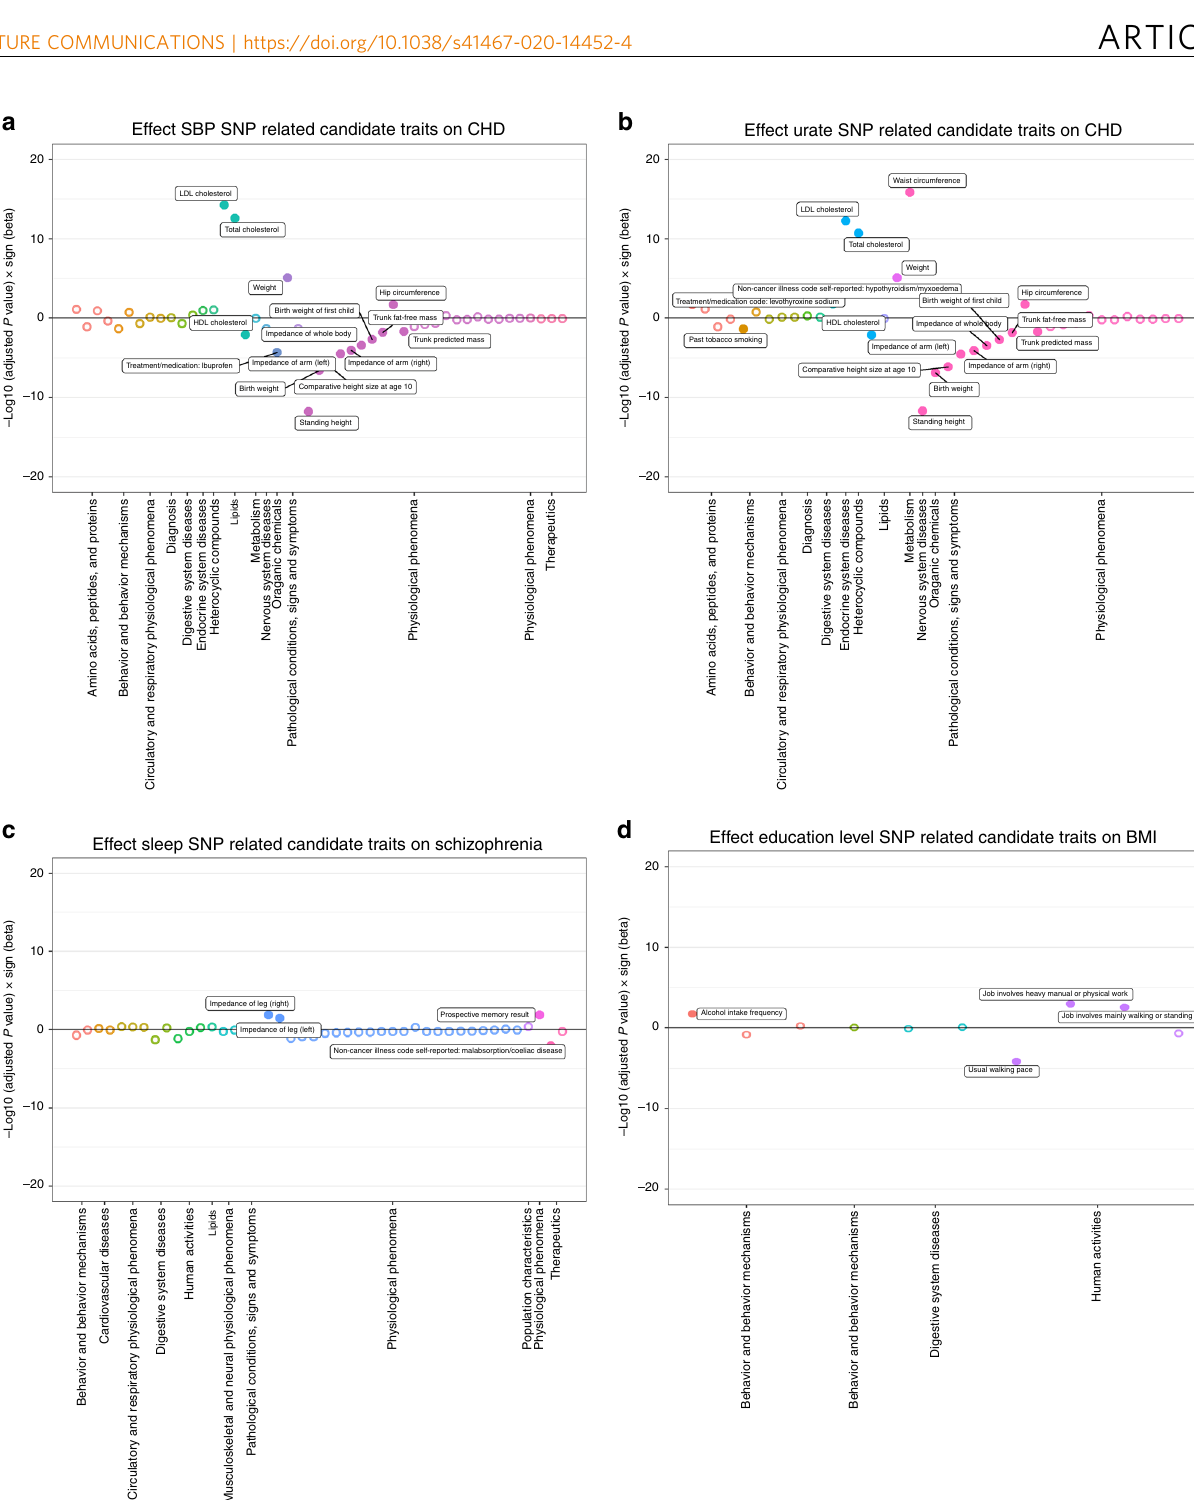
Fig. 3 Causal associations between candidate exposures and hypothesised outcome. Each candidate trait related to an outlier from an analysis is represented by a point in these plots. Along the x- axis, different phenotype groups are shown in different colours. The y- axis presents log transformed P value for each trait, multipled by the sign of the causal effect estimate on the outcome. Filled circles in each category indicate the evidence of association between candidate traits and exposure or outcome (using an FDR<0.05 threshold; see Methods for discussion of this). a Empirical analysis 1: systolic blood pressure (mmHg) and coronary heart disease (log odds). b Empirical analysis 2: urate (mg/dl) and coronary heart disease (log odds). c Empirical analysis 3: sleep duration (hour/ night) and schizophrenia (log odds). d Empirical analysis 4: years of schooling (years) and body mass index (kg/m 2